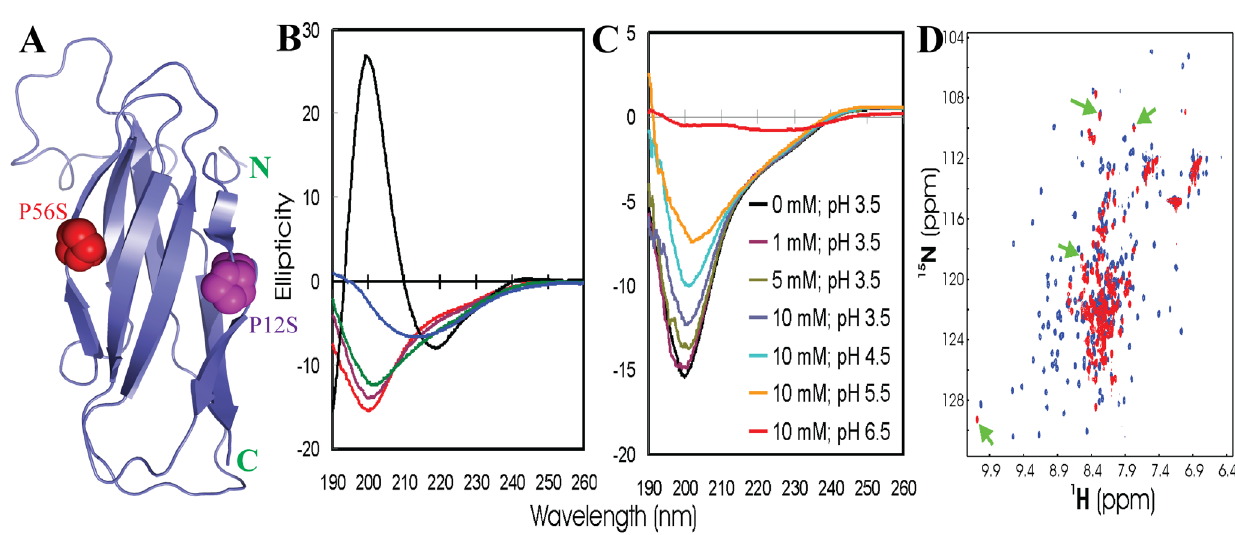
Figure 12. Conformational properties of the wild-type and P56S- MSP domain. ( A ) Crystal structure of the wild-type VAPB MSP domain, with Pro12 and Pro56 displayed in spheres. The two Pro residues appear to play a key role in maintaining two characteristic S-shaped loops in the MSP domain. ( B ) Far-UV CD spectra of the wild-type MSP (black) and P56S mutant at pH 3.5 (red), 4.5 (brown), 5.5 (green), and 6.5 (blue). ( C ) Far-UV CD spectra of the P56S mutant at different pH values and salt concentrations. ( D ) Superimposition of the HSQC spectra of the wild-type MSP domain (blue) and P56S mutant at pH 3.5 (red).